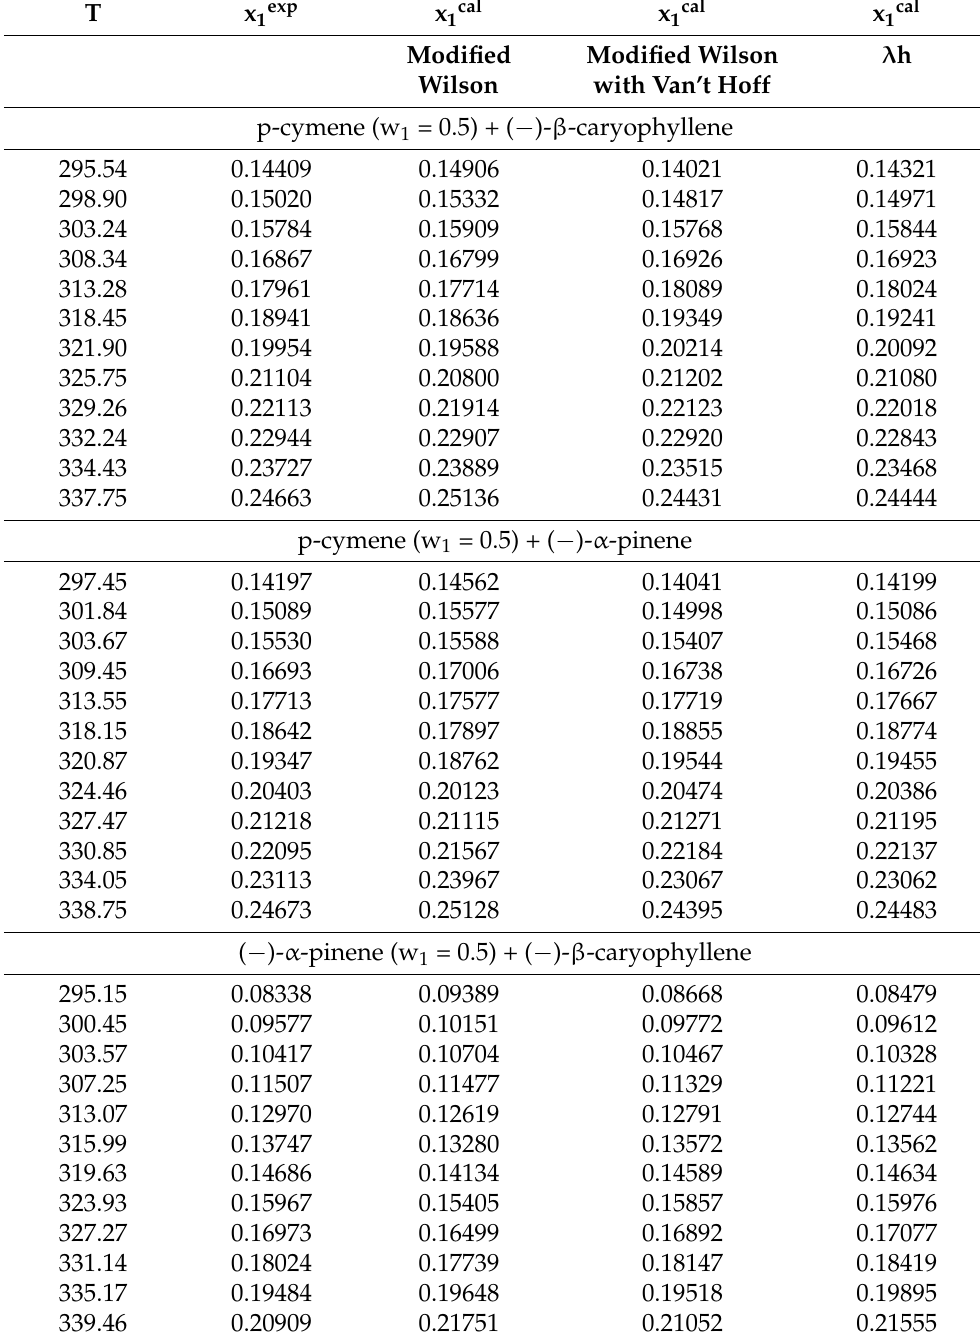
Table 3. Values of experimental mole-fraction solubility ( x 1 exp ) and calculated solubility data ( x 1 cal ) of dehydroabietic acid in three binary solvents (p-cymene + ( − )- β -caryophyllene, p-cymene + ( − )- α -pinene, and ( − )- α -pinene + ( − )- β -caryophyllene) at different temperature T and pressure P = 101.3 kPa a